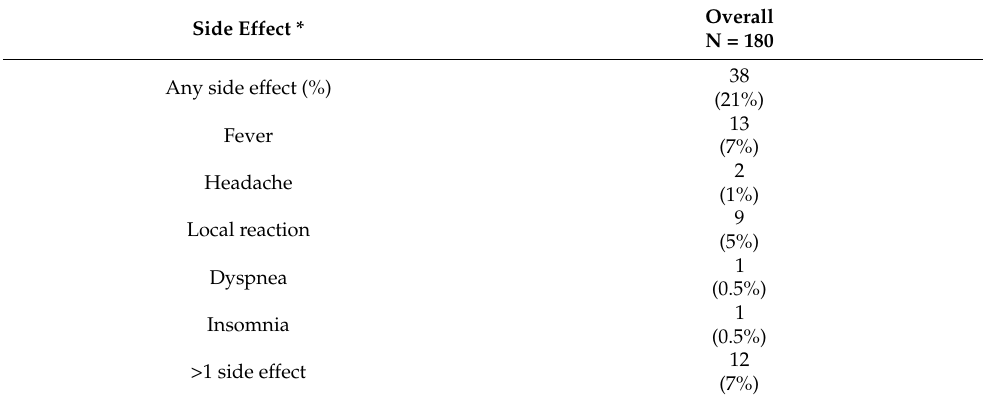
Table 2. Side effects of the vaccination.